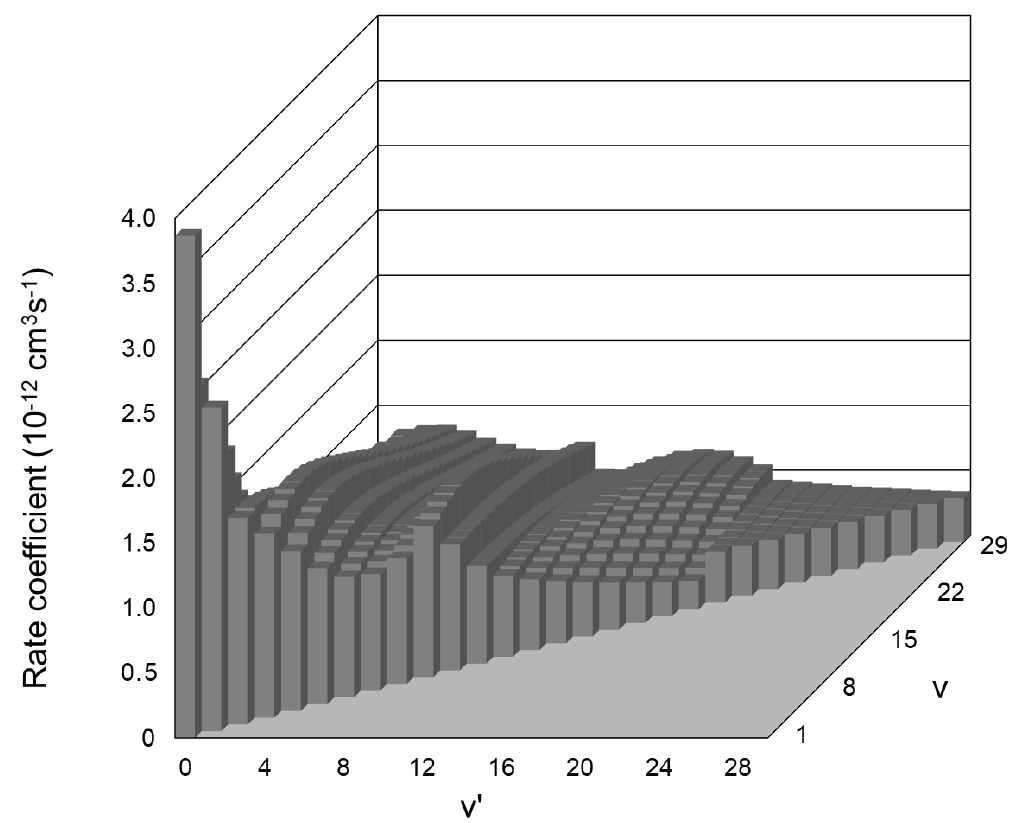
Figure 6. Rate coe ffi cients of O 2 (X 3 Σ g − , v ≤ 30) + O( 3 P) → O 2 (X 3 Σ g − , v (cid:48) = v − ∆ v) + O( 3 P) depending Figure 6. Rate coefficients of O 2 (X 3 Σ g ̄ , v ≤ 30) + O( 3 P) → O 2 (X 3 Σ g ̄ , v’ = v − Δv) + O( 3 P) depending on v on v and v (cid:48) and v’ [62].